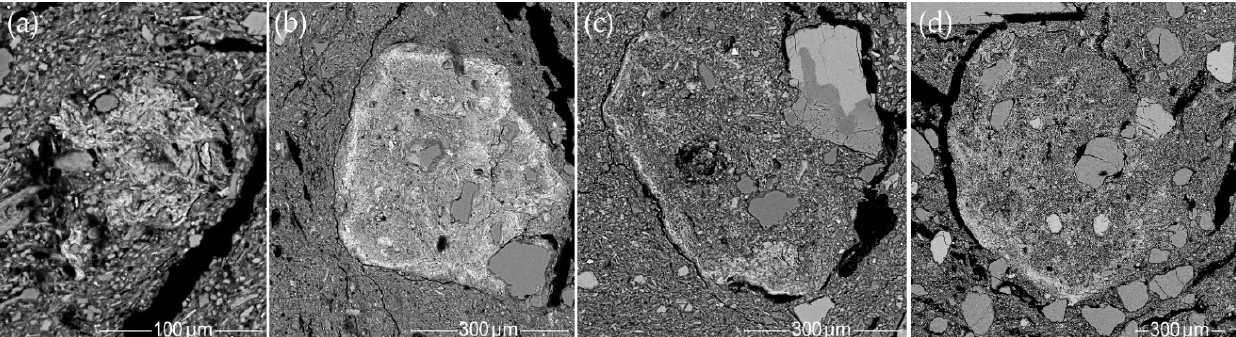
Figure 16. SEM BSE images of ferruginous nodules: ( a ) mica structure seen at 1000× magnification (CW-E_M1); ( b ) the matrix of very low-temperature-fired clay (CW-E_M3); ( c ) the matrix of low-temperature-fired clay (HG-E_M5); ( d ) the matrix of medium-temperature-fired clay (CW-E_M1). Ferruginous nodules are characteristic of micaceous clay matrix fired at both very low and medium temperatures, differing only in their appearance. In very low-temperature- fired clay, the edges of the nodules appear diffuse (Figure 16b), while in the clay matrix fired at low to medium temperatures (due to the shrinkage of the clay) clear boundaries are visible, marked by contraction voids (Figure